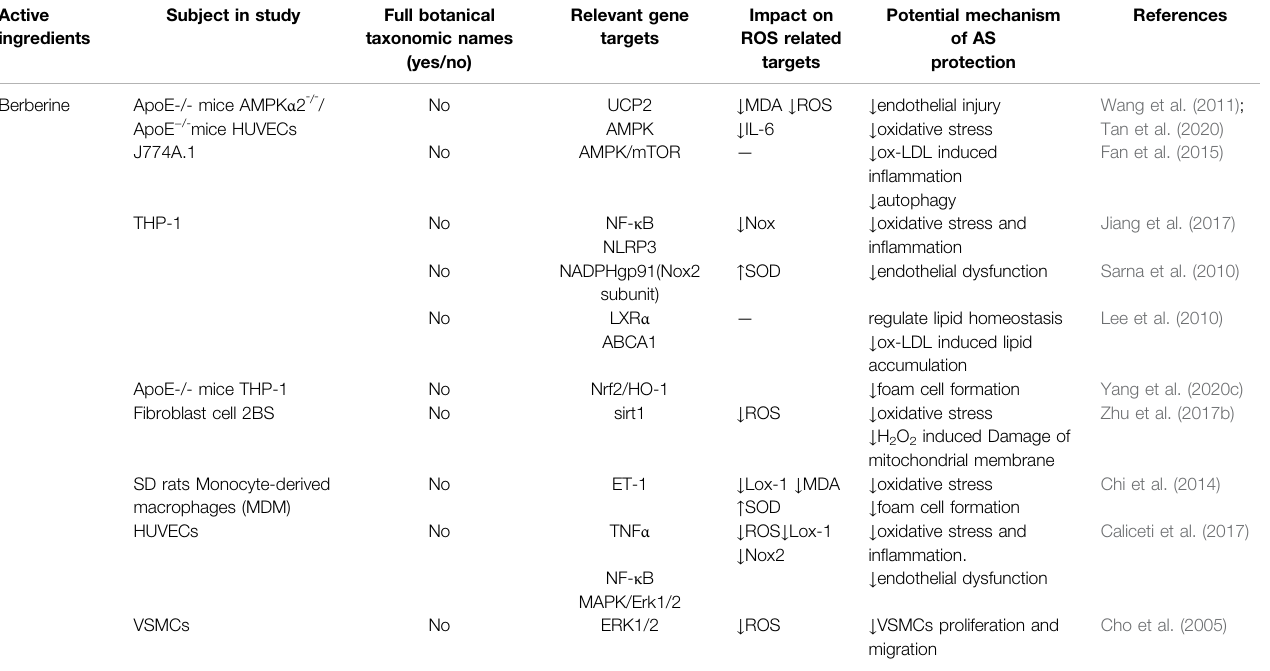
TABLE 5 | Berberine for treatment of atherosclerosis by regulating oxidative stress. Active